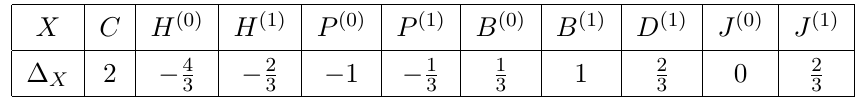
Table 1 . Dilatation weights of the symmetry generators for L 2 . Weights of t are the opposites of H (0) , H (1) , P (0) and P (1) ,